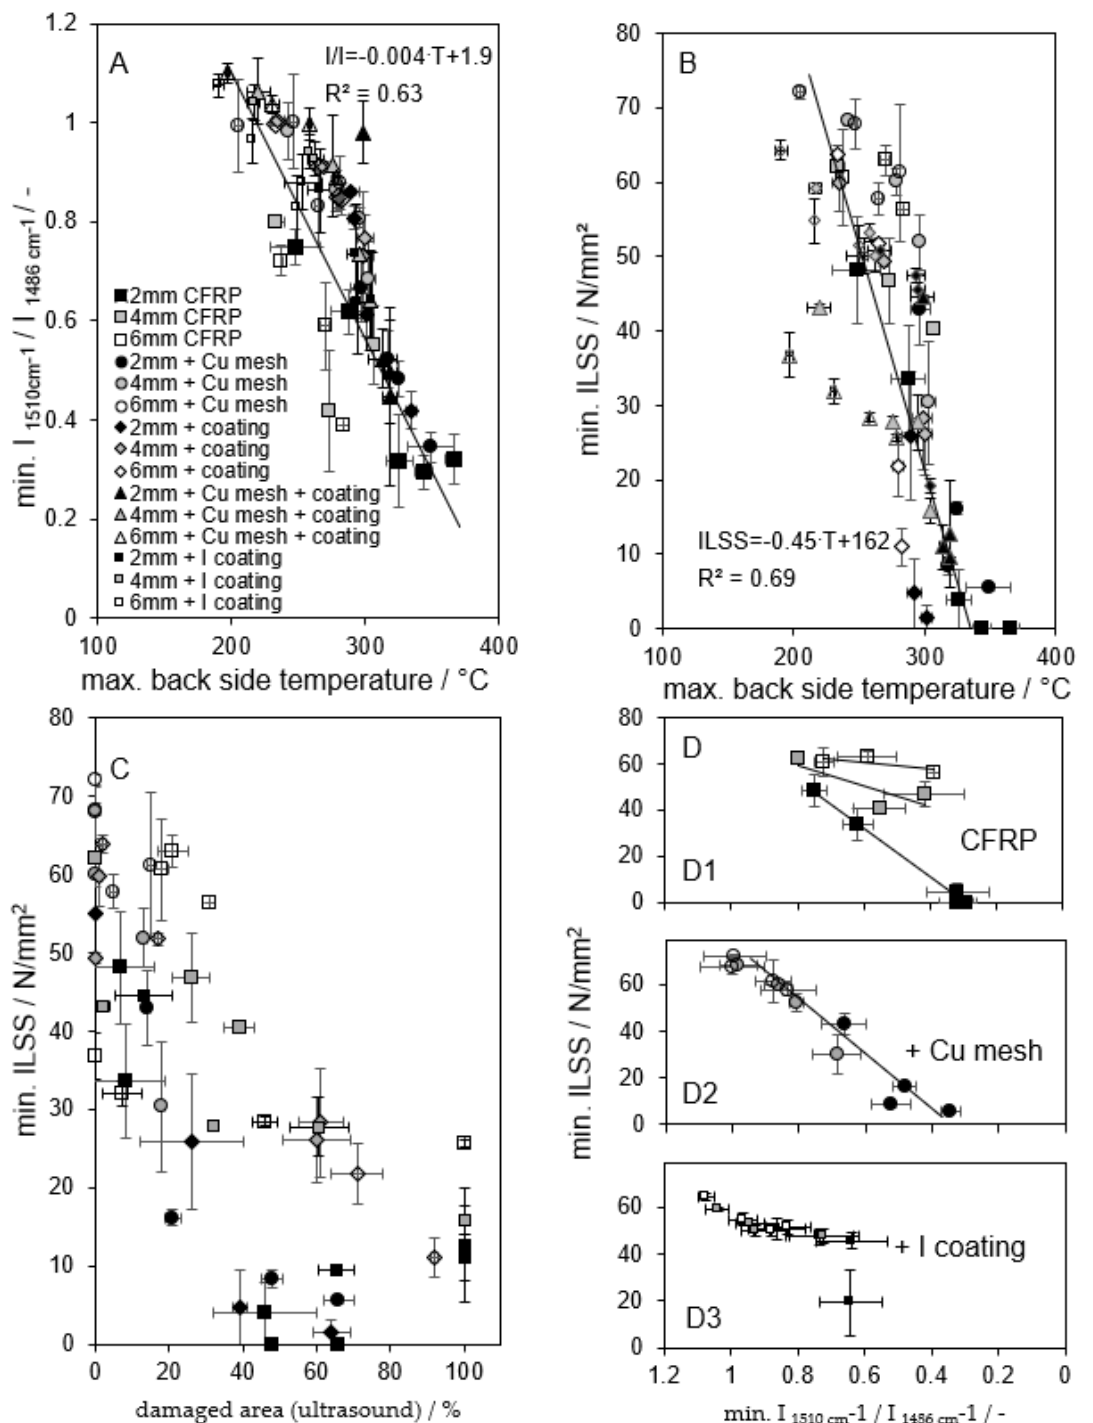
Figure 18. Correlation of data for 8552/IM7 panels after impact of fire accelerant:( A ) matrix degradation characterized by IR-spectroscopy (min. I 1510 cm − 1 /I 1486 cm − 1 ) with max. backside temperature; ( B ) residual ILS-strength with max. backside temperature; ( C ) ratio of damaged area in ultrasonic C-scan and minimum ILSS; ( D ) minimum ILSS and matrix degradation characterized by